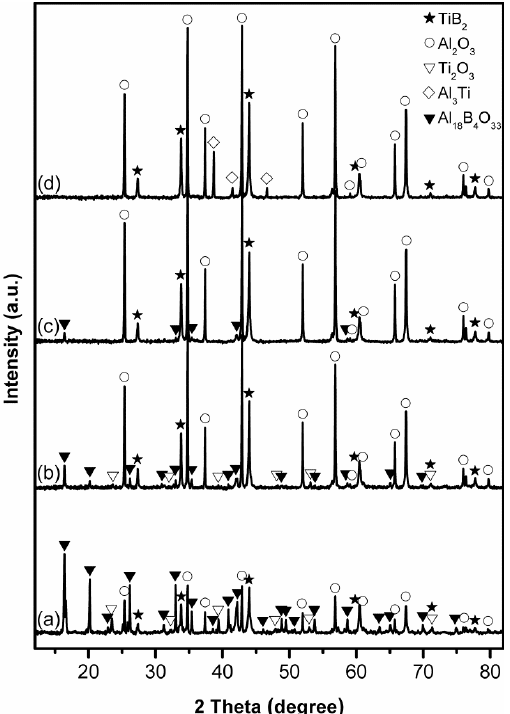
Figure 3. XRD patterns of samples using ( a ) 0, ( b ) 20, ( c ) 25, and ( d ) 30 wt% excess Al, after 4 h firing in NaCl at 1150 °C.